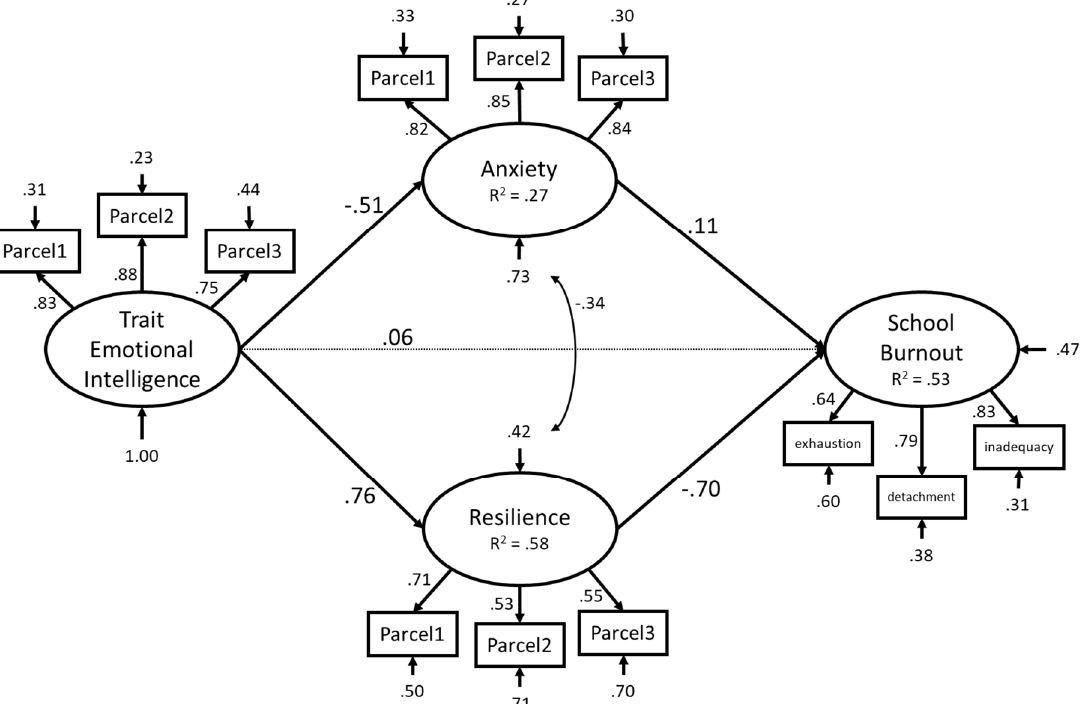
Figure 1. Structural equation model interlinking trait emotional intelligence (TEI), anxiety, resilience, and school burnout. Coefficients shown are standardized path coefficients. Parcels represent aggregation of items used as indicators of latent constructs. Paths from age are omitted for presentation purposes and are: age–TEI: β = 0.01; age–anxiety: β = − 0.07; age–resilience: β = − 0.09; age– school burnout: β = 0.10).